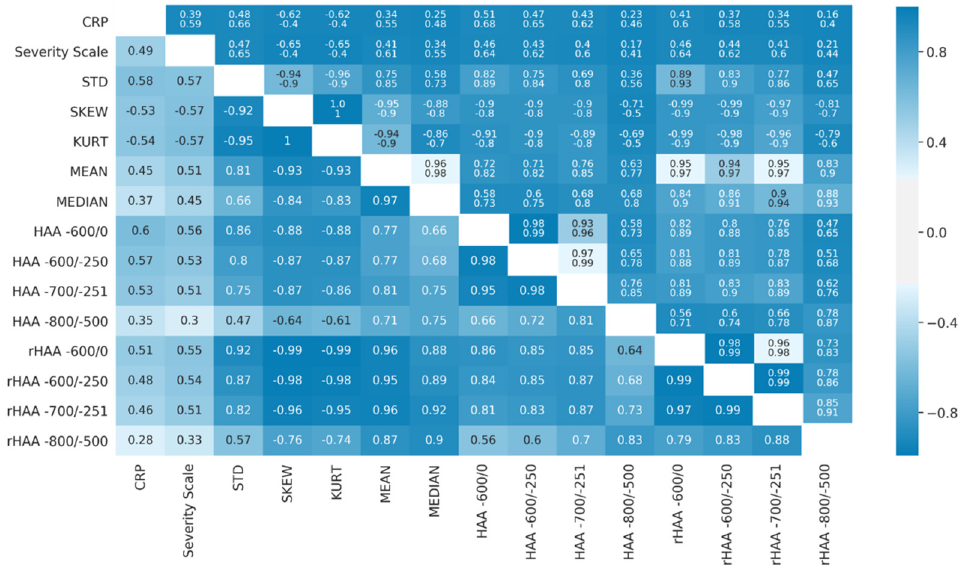
Figure 5. Spearman rank correlations (lower triangle) and 95% confidence intervals (upper triangle, with the lower confidence interval in the first row and the upper in the second row, respectively) of imaging biomarkers with clinical parameters (CRP and clinical severity scale). The colormap applies to the Spearman rank correlation values and the range of confidence intervals. Abbreviations: NECT = non-enhanced computed tomography. STD = histogram standard deviation. SKEW = skewness. KURT = kurtosis. MEAN = mean lung attenuation. MEDIAN = median lung attenuation. HAA = high attenuation area. rHAA = relative high attenuation area.